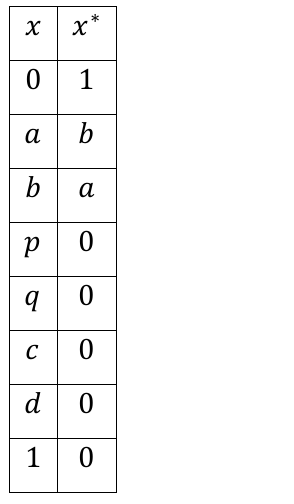
Table 3.3: Complement Table 3.4: